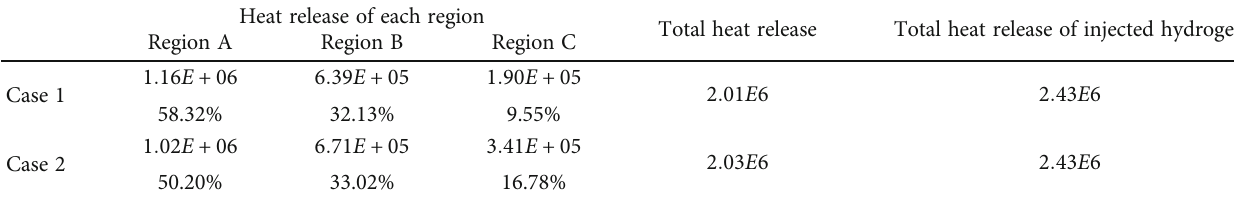
Table 3: Heat release of each region and its